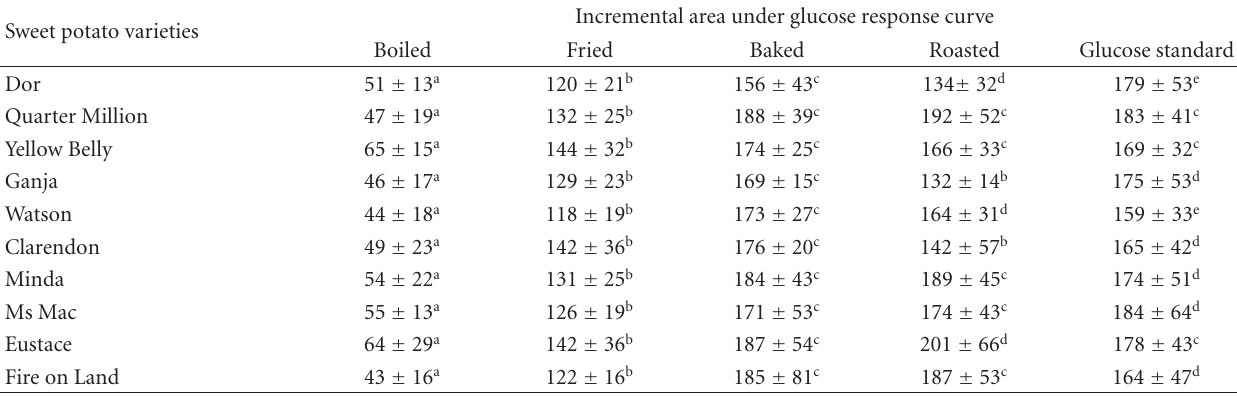
Table 4: Incremental areas under the glucose response curves for ten sweet potato ( Ipomoea batatas ) cultivars processed by di ff erent cooking methods and glucose standard. Sweet potato